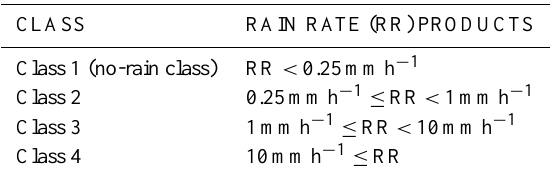
Table 5. Classes for instantaneous rain rate. Table 6. Classes for cumulated